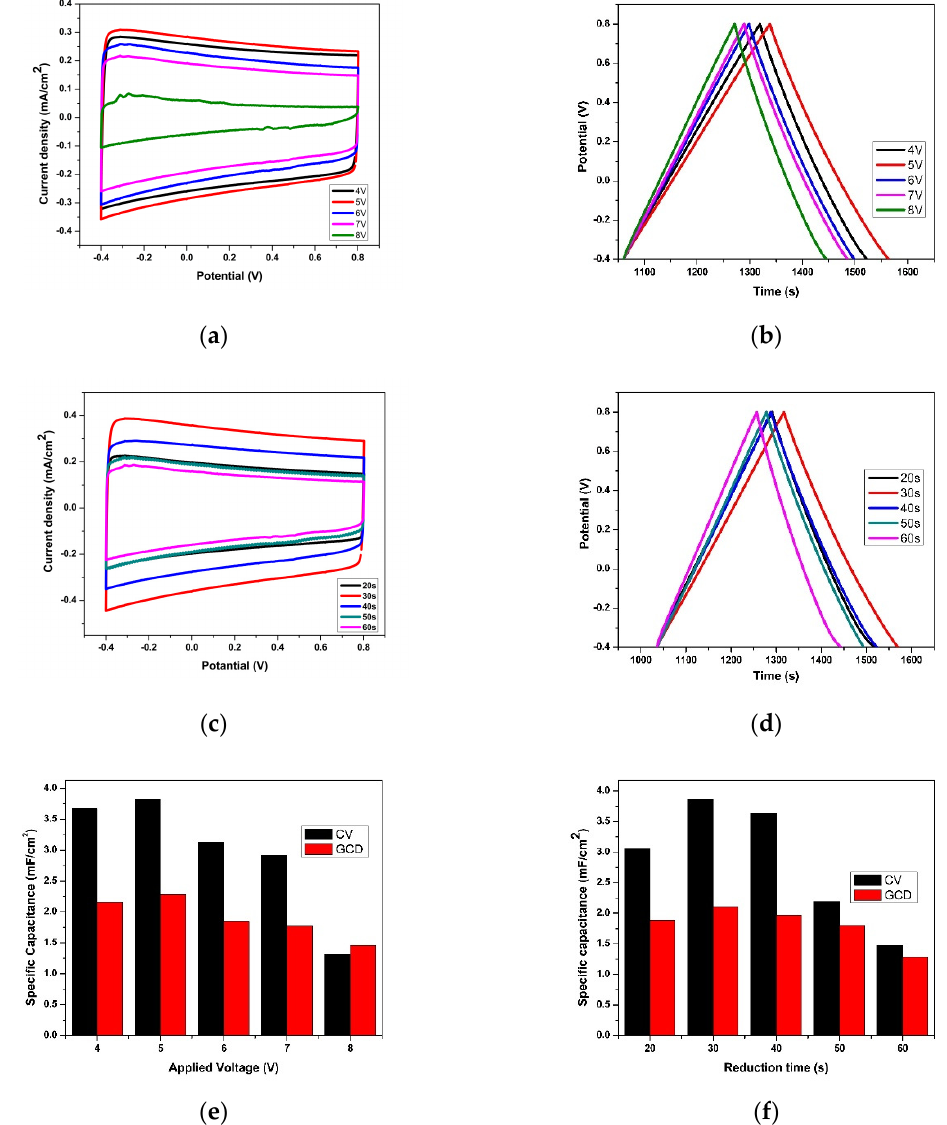
Figure 8. CV voltammograms of R-TNTs at scan rate of 200 mV s − 1 recorded at different ( a ) reduction voltages and ( c ) times. GCD curves of R-TNTs at current density of 0.02 mA cm − 2 recorded at different ( b ) reduction voltages and ( d ) times. Variation of specific capacitance as a function of ( e ) reduction voltages and ( f ) times.